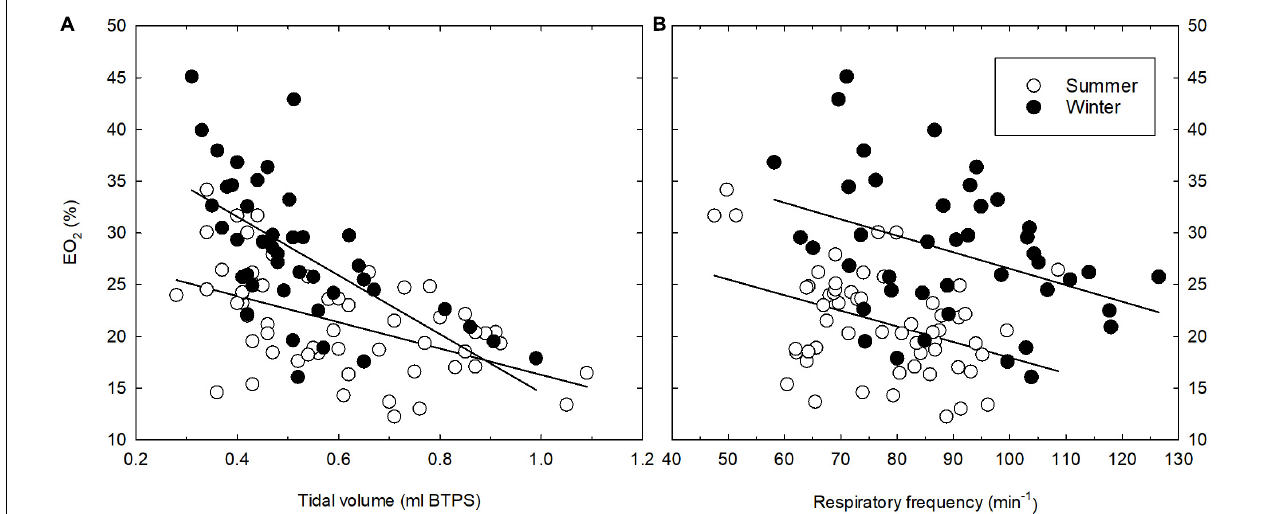
FIGURE 4 | Relationship between tidal volume (A) and respiratory frequency (B) and lung oxygen extraction (EO 2 ) in summer- (open symbols) and winter-acclimatized (closed symbols) great tits. Each point shows the mean value for an individual bird at a single ambient temperature. See text for